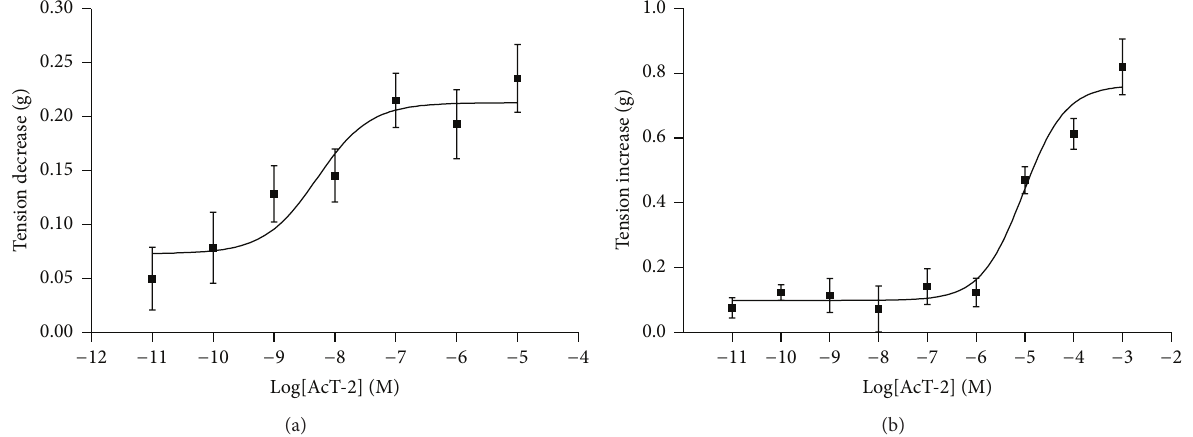
Figure 3: Dose-response curves obtained using synthetic AcT-2 on rat smooth muscle preparations. (a) Effect of the peptide on tail artery smooth muscle preparations expressed as means and standard errors ( 𝑛 = 6 ). EC 50 was found to be 5.1 nM. (b) Effect of the peptide on urinary bladder smooth muscle preparations expressed as means and standard errors ( 𝑛 = 6 ). EC 50 was found to be 9.3 𝜇